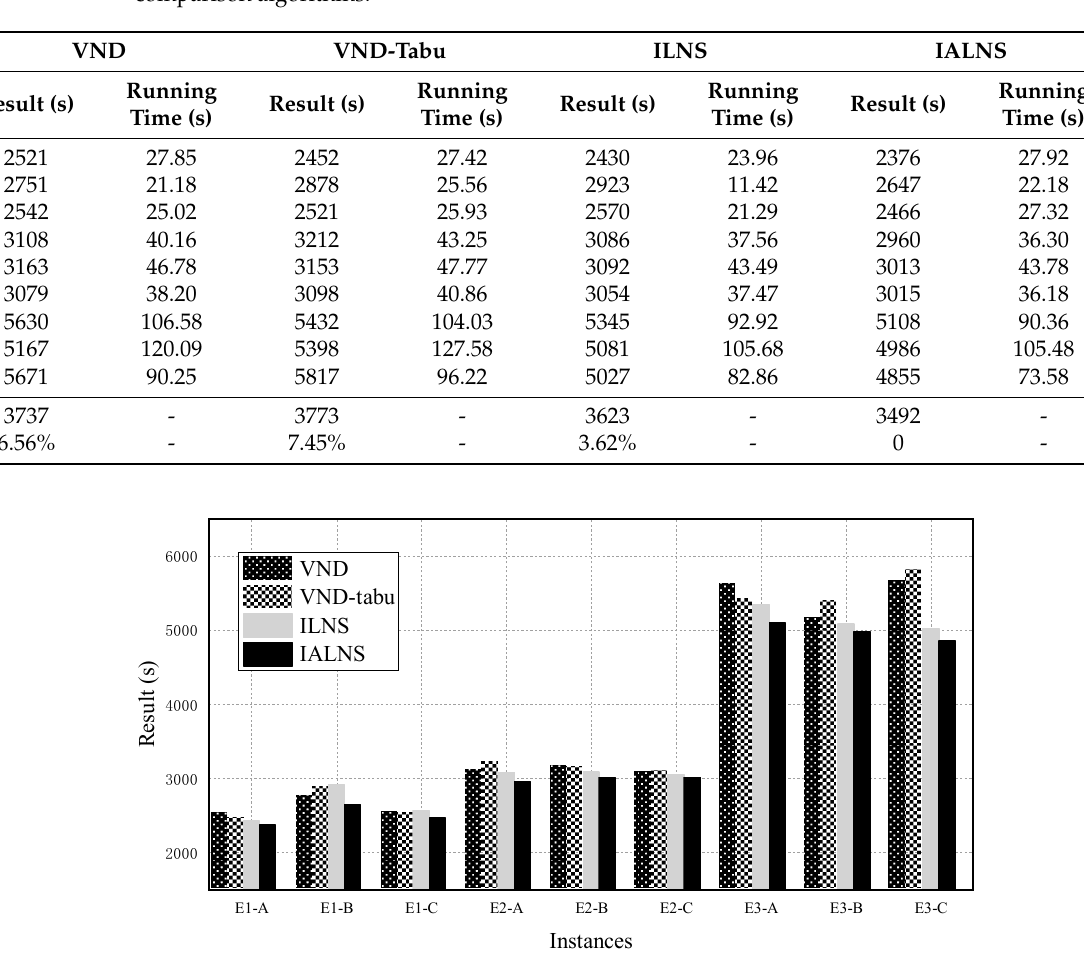
( c ) Figure 13. Schematic diagrams of route planning results on different instances with different num- ber of target edges. ( a ) E1-A; ( b ) E2-A; ( c ) E3-A. To further verify the stability of each algorithm, the statistical results of the standard deviation of different algorithms are obtained, as shown in Table 6. Each algorithm was independently run 20 times. “Max“, “Min” and “Avg” are the maximum, minimum, and average values of the standard deviations of the nine instances, respectively. Table 6. The statistical results of the standard deviation of different algorithms. Instances Total Num. of Target Edges